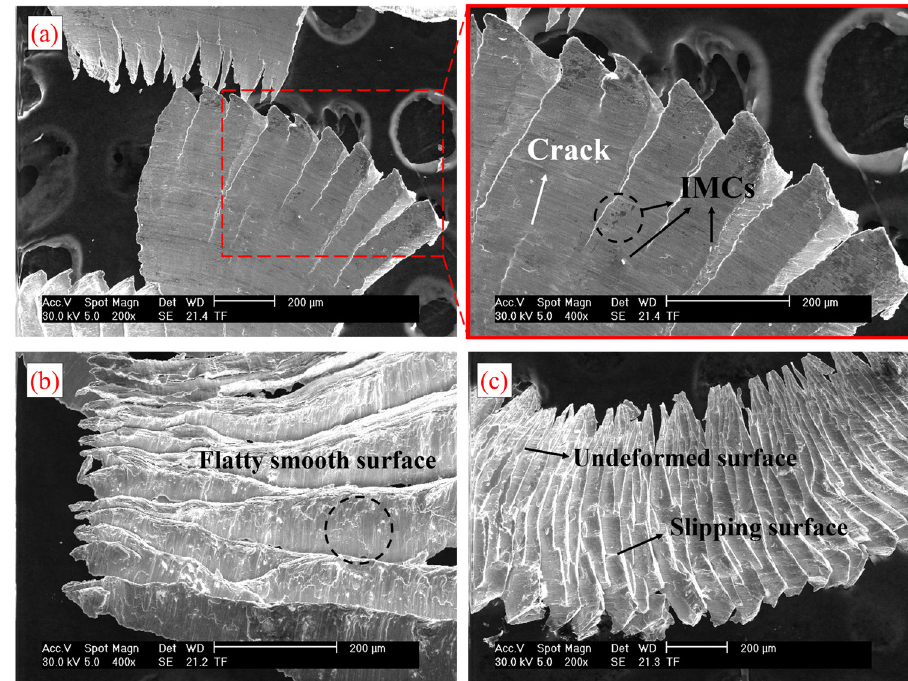
Figure 9: SEM images of chip surface morphology: ( a ) Ecobrass, ( b ) F.C.B, and ( c ) MoS 2 - 3.